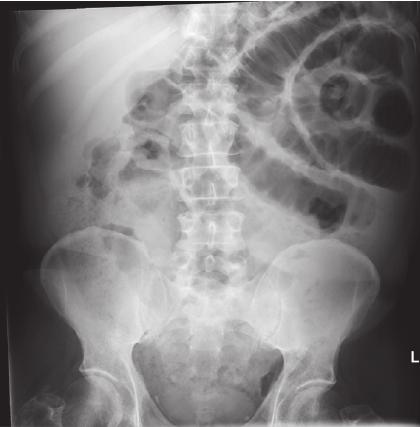
Figure 3: CT abdomen coronal view after IV contrast. There is significant dilatation noted in the loops of the small intestines and some of them showed diffuse wall thickening. There is a large amount of free fluid noted in the abdomen and pelvis. There is free air noted in the abdomen and pelvis indicating bowel perforation. May